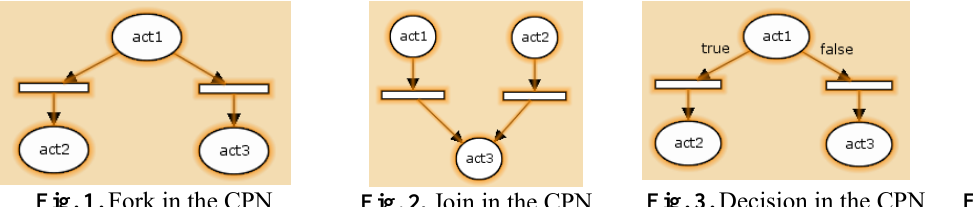
Fig. 1. Fork in the CPN Fig. 2 . Join in the CPN Fig. 3. Decision in the CPN Fig. 4. Merge in the CPN